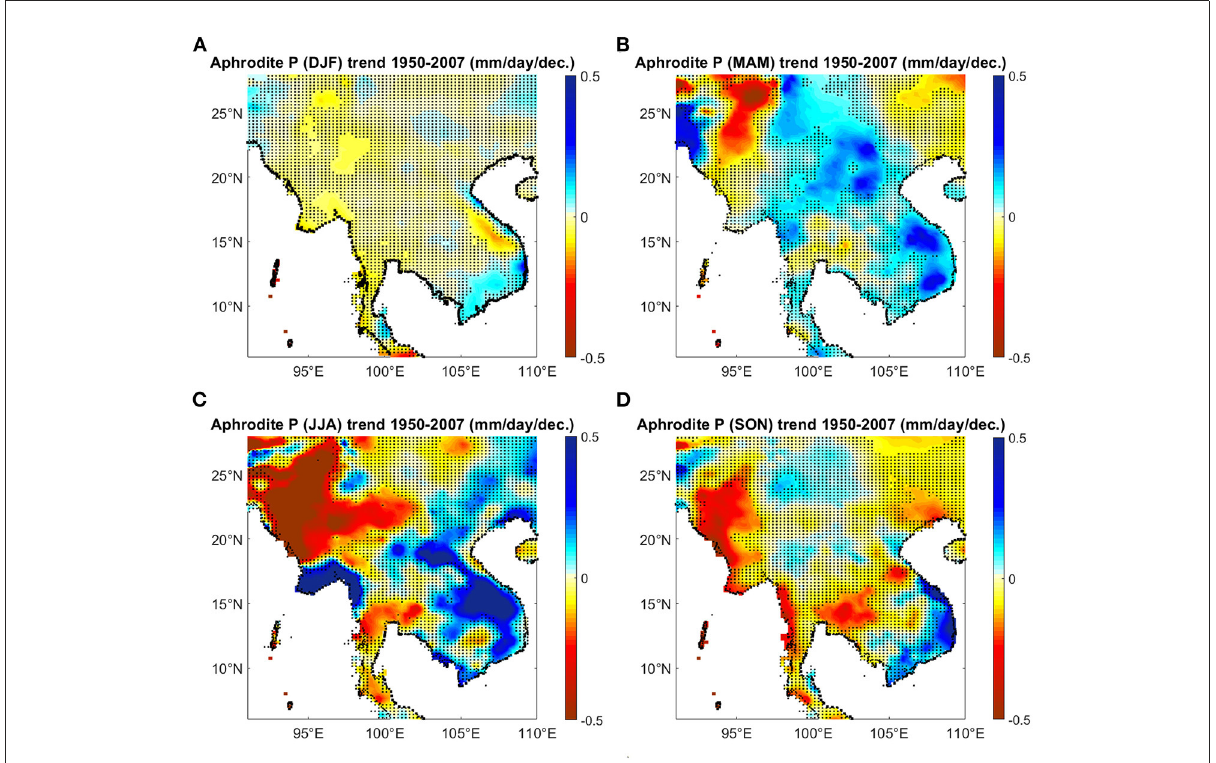
FIGURE3 Seasonal precipitation trends (mm/day/decade over 1950–2007 based on the rain-gauge-based APHRODITE dataset: (A) Winter (Dec–Feb); (B) Spring (Mar–May); (C) Summer (Jun–Aug); (D) Autumn (Sep–Nov). Regions where the linear trend is not significant at the 95% confidence interval are